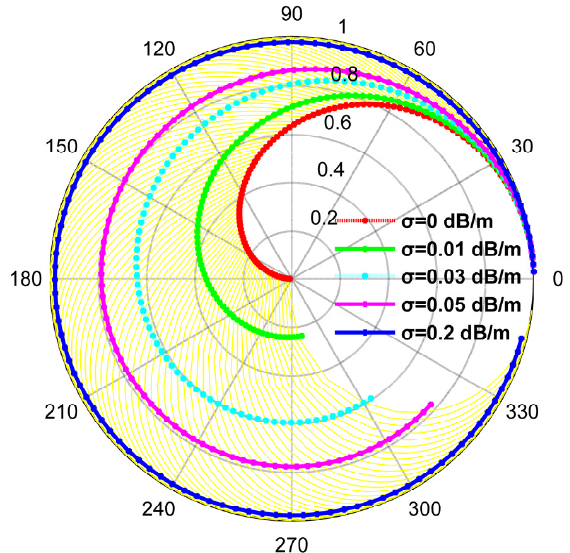
Figure 2. Volume complex coherence changes with forest height and extinction at k z = 0.1154. Note: Calculate k z = 0.1154 and ha = 54.4470 m from the setting parameters. Different color curves corresponded to different extinction coefficients. With larger extinction or strong ground scattering, the pure volume complex coherence amplitude was prone to saturation (such as the blue curve), but the phase was not saturated. When the extinction coefficient was in the range of 0~2 dB/m (such as yellow curves), the pure volume complex coherence changed with forest height h v (0~ ha m, step is 0.5 m). When the forest height was the same (any yellow curve) and pure volume complex coherence scattering amplitude was large, this was caused by surface scattering or the strong attenuation of vegetation. Complex coherence fell with increasing vegetation height, as a consequence of volume decorrelation. 3.2. Methods In this paper, without considering baseline and coregistration error, topography, or temporal and signal-to-noise ratio (SNR) decorrelation sources, we introduced PD/MCD coherence optimization to solve for incomplete coherence separation in the three-stage inversion [13]. Additionally, we introduced complex coherence amplitude inversion [36] to solve the underestimation or overestimation problem and introduced the ground scatter ratio to automatically select the weight to improve the three-stage method. We compared and analyzed these methods combined with the topographic phase affecting forest height. A technical roadmap is shown in Figure 3.